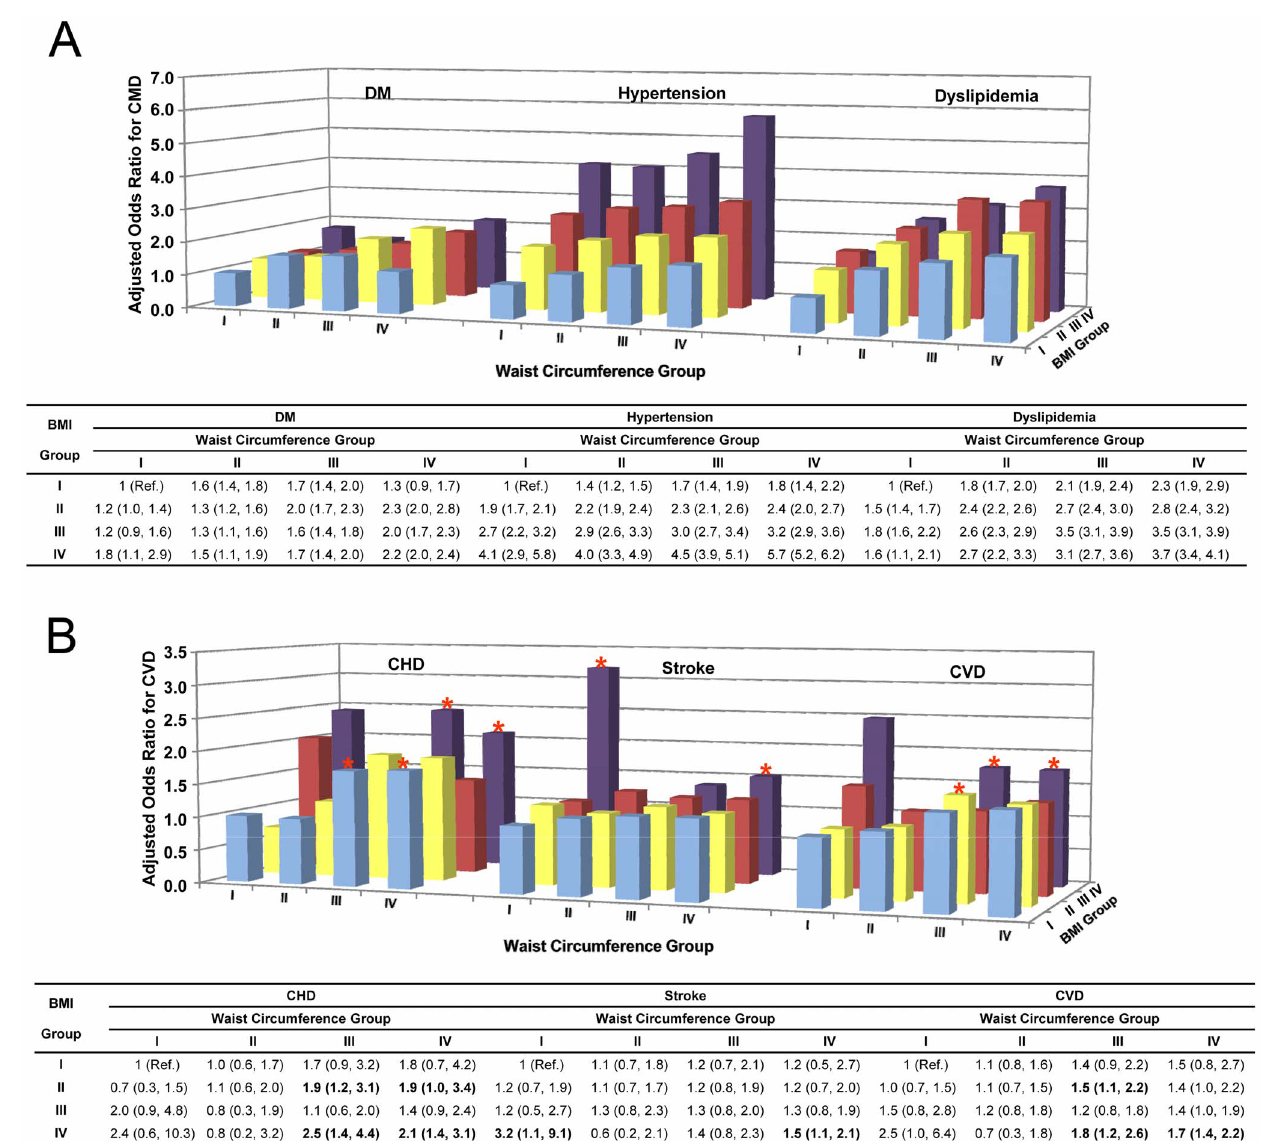
Figure 2. ORs for CMD and CVD among the combination groups of WC and BMI categories. Binary multivariable logistic regression was conducted to assess the association of combined WC and BMI categories with CMD (Figure 2A) and CVD (Figure 2B) using the Entry method and the adjusted odds ratios (ORs) and the 95% CIs were given. The dependent variables were CMD (DM, hypertension, and dyslipidemia) and CVD (CHD, stroke, and CVD).The independent variables were the combination group of WC and BMI categories. Adjustment variables included the basic confounders (gender, age, education levels, smoking status, drinking status, physical activity) and family history of diseases (the disease in accordance with the dependent variables) in Figure 2A . In Figure 2B , CMD (DM, hypertension, and dyslipidemia ) were also considered as confounders besides the adjustment variables in Figure 2A . * P , 0.05 was asterisked only in Figure 2B. Abbreviations: BMI, body mass index (calculated as weight in kilograms divided by the square of the height in meters); CHD, coronary heart disease; CI, confidence interval; CVD, cardiovascular disease; DM, diabetes mellitus; OR, odds ratio; TG, triglycerides; WC, waist circumference.